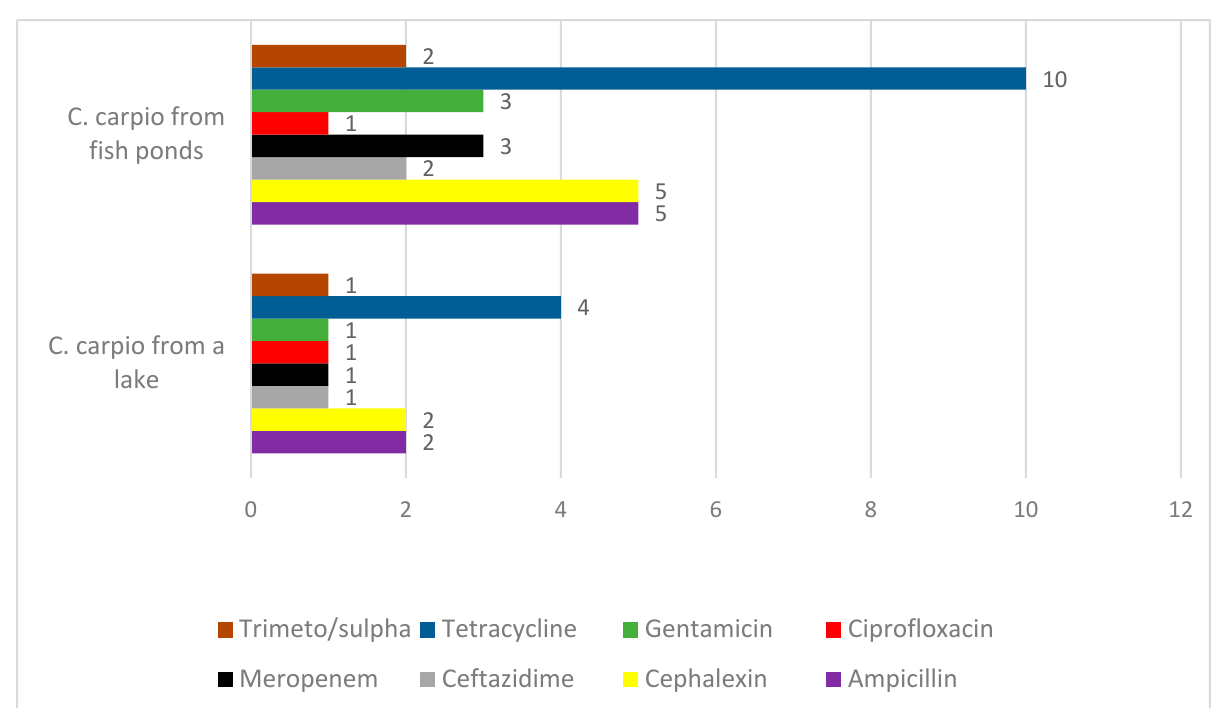
Figure 6. The number of resistant isolates of Enterobacteriaceae isolated from carps.